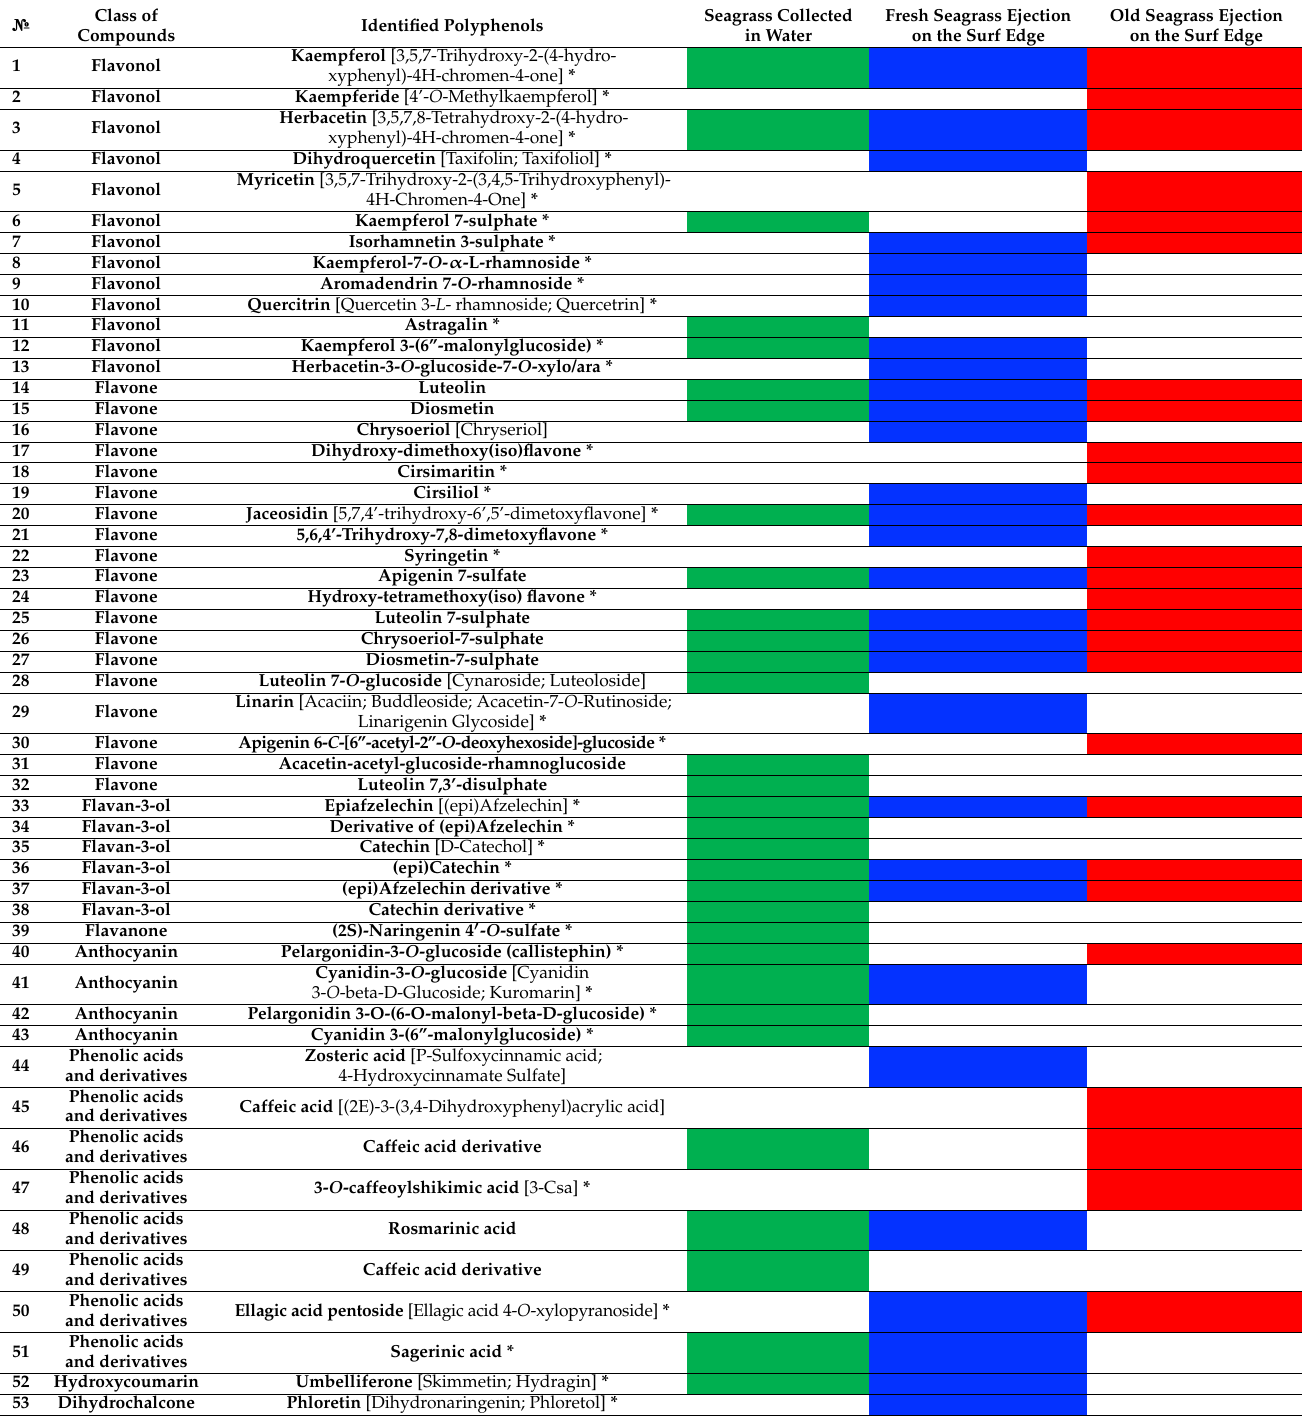
Table 1. Identified polyphenols by tandem mass-spectrometry in three samples: eelgrass collected in water; fresh eelgrass ejection on the surf edge; old eelgrass ejection on the surf